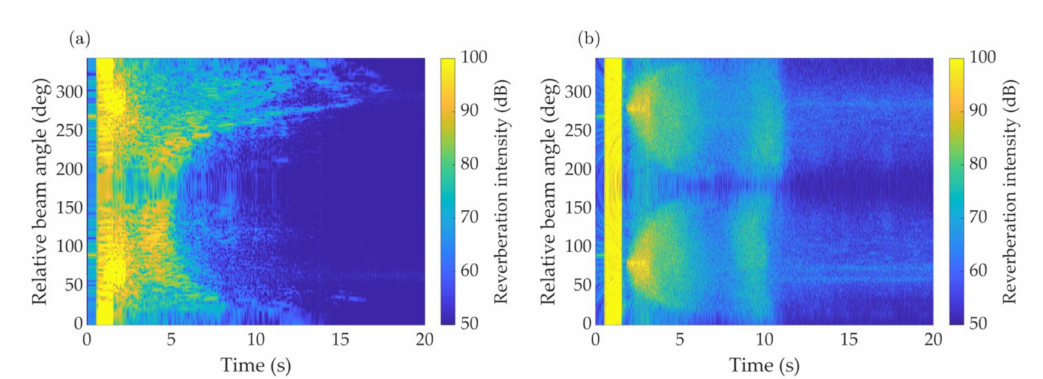
Figure 9. Beam time series at two di ff erent sites for the time and relative beam angle measured clockwise from the bow direction. ( a ) Ping 107 (CW ping, pulse duration 1 s, z s = 135 m, z r = 129 m),